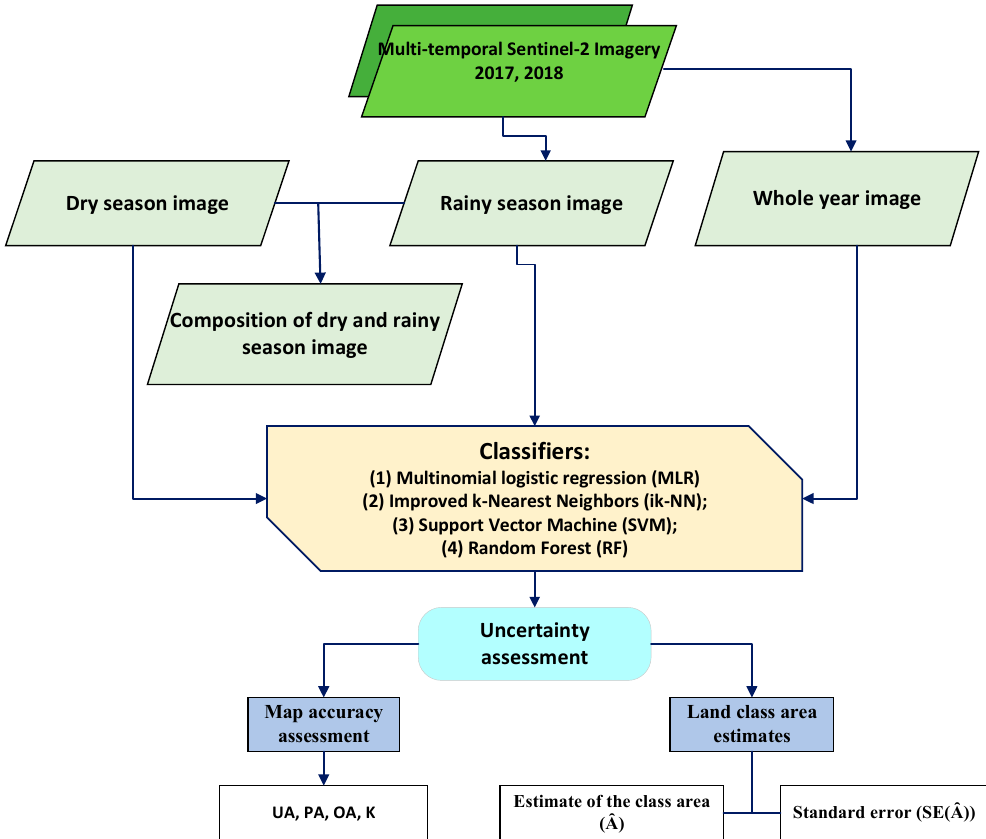
Figure 1. Research approach as a flowchart. The Sentinel-2 2017 and 2018 data were collected for different seasons: dry, rainy, whole year, and rainy and dry composited images. The MLR, ik-NN, SVM, and RF classifiers were tested with the resulting uncertainty assessments used as criteria for comparing combinations of seasonal datasets and classifiers. OA, overall accuracy; K, Kappa coefficient; PA, producer’s accuracy; UA, user’s accuracy.